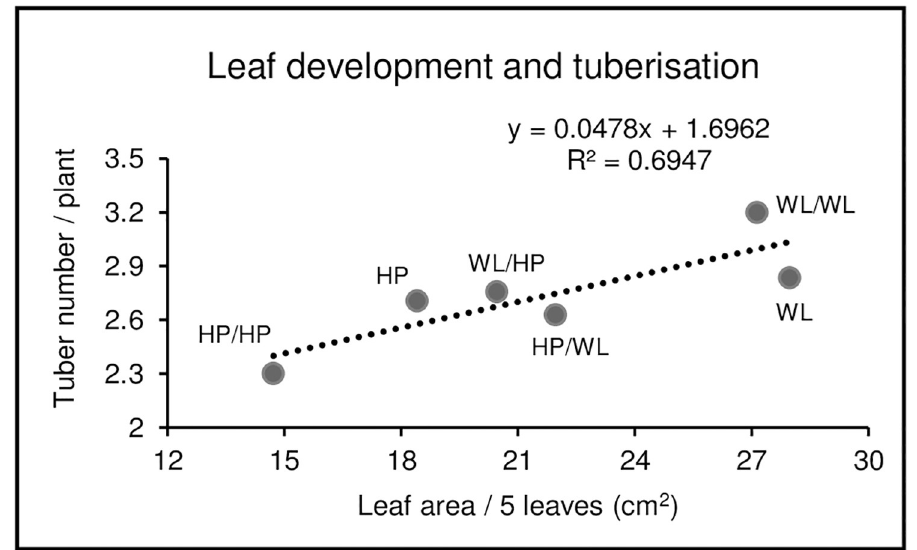
Fig 2. Correlation between leaf size and tuberisation six weeks after grafting. The area of the five largest leaves per plant was measured. Three consecutive experiments were carried out. In sum, 20–25 plants were tested in each experiment. HP, non-grafted control Ho´pehely; WL, non-grafted control White Lady; HP/HP, homo-grafted Ho´pehely; WL/WL, homo-grafted White Lady; HP/WL, hetero-graft: Ho´pehely scion/White Lady rootstock; WL/HP, hetero-graft: White Lady scion/Ho´pehely